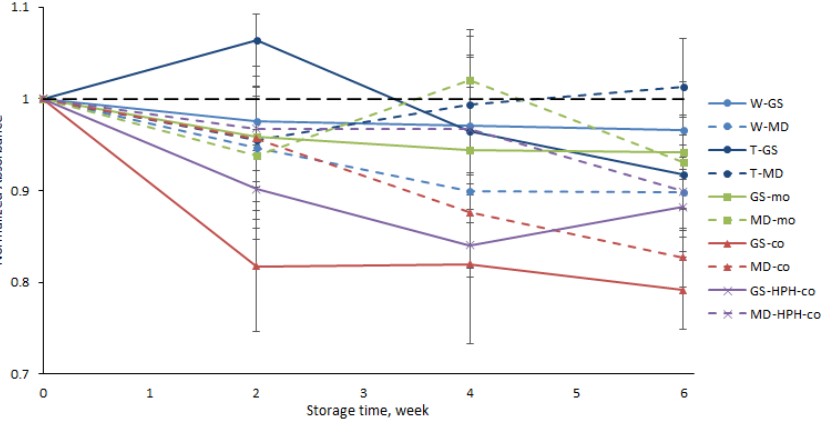
Figure 5. Oxidative stability levels measured using FT-IR of the of the fish-oil-loaded capsules produced by spray-drying or electrospraying (monoaxial and coaxial) during